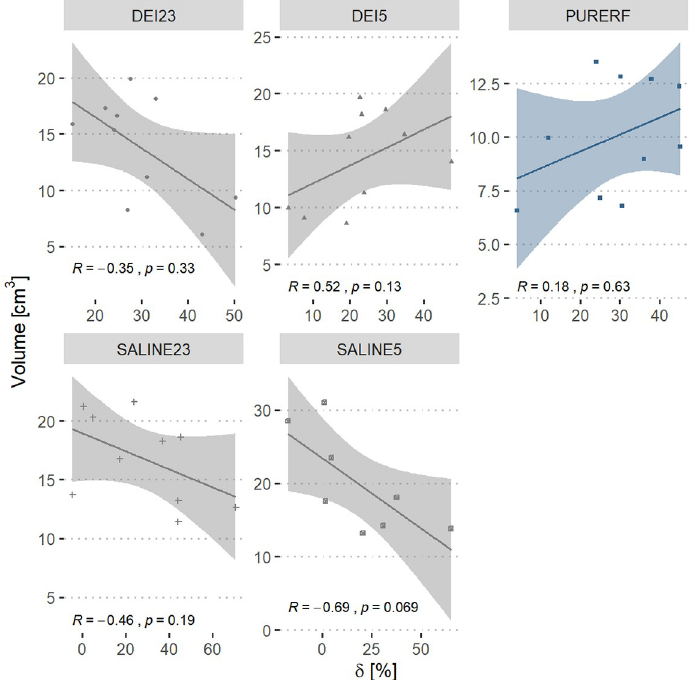
Fig 6. Correlation between performance index δ and volume. The graph displays the correlation between volume in the groups and the index δ . The PURERF group shows weak evidence of a positive correlation. The SALINE5 group shows the highest evidence of negative correlation (R = -0.69 and p = 0.069).